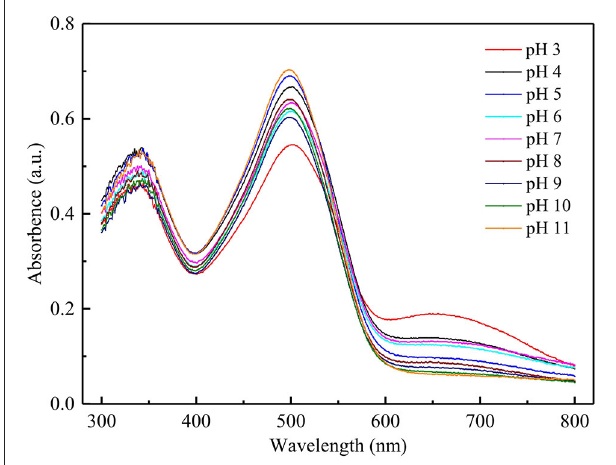
FIGURE 6 | The UV-vis absorbance spectra of CR within experimental pH range.